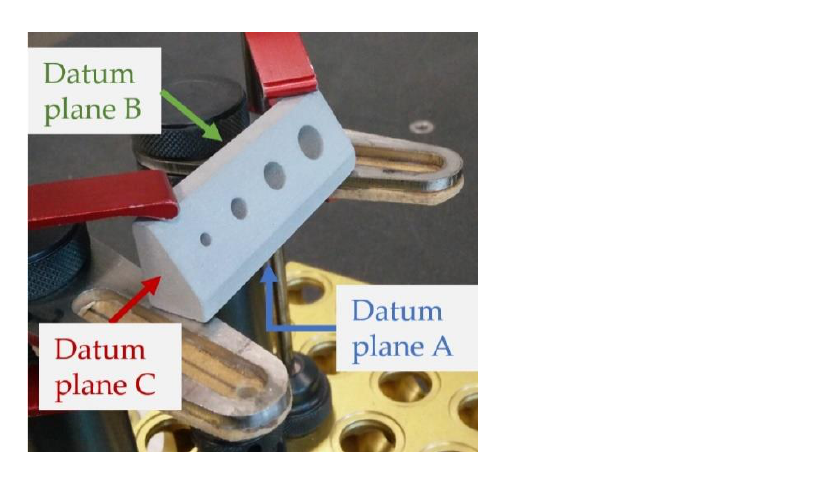
Figure 4. Example of the clamping system and the datum planes used for the alignment procedure.